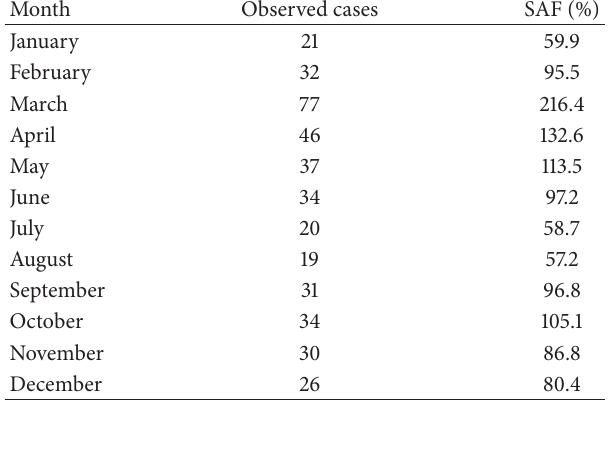
Figure 3: Actual (observed) and predicted (fit) values of tuberculo- sis cases.